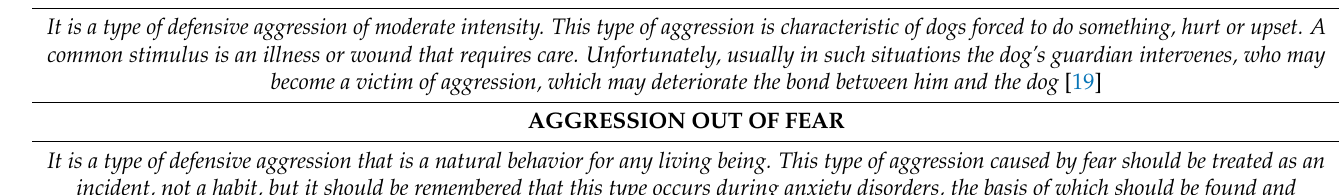
Table 1. Cont. AGGRESSION FROM